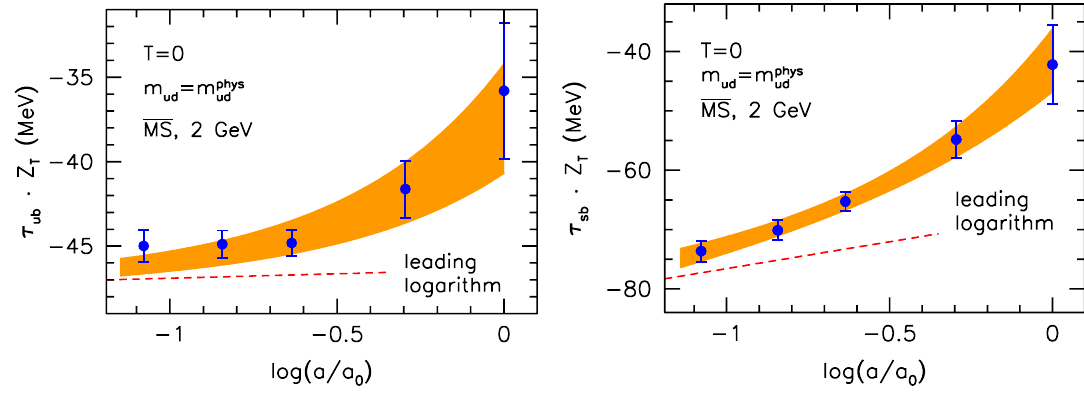
Figure 7 . The bare tensor coe(cid:14)cient for the up quark (left panel) and for the strange quark (right panel) at the physical point and at zero temperature (blue points), together with an interpolation (orange bands). For the up quark this interpolation is the m ud = m phys like in (cid:12)gure 6. The red dashed lines indicate the leading logarithmic divergence / m f log a in both (cid:12)ts. The remaining a -dependence is consistent with lattice artifacts. We always use m s = m phys